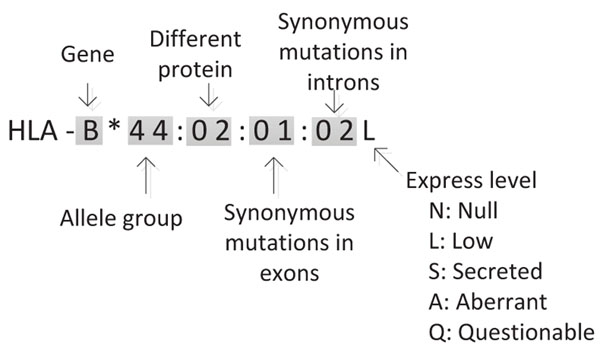
HLA nomenclature